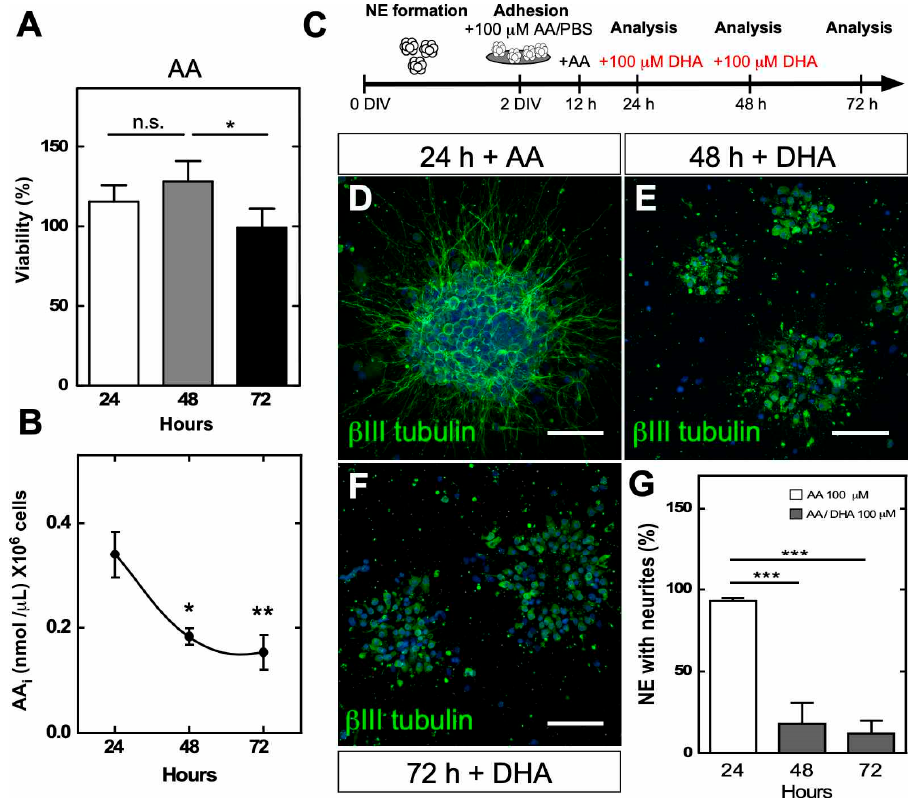
Figure 3. Treatment of NEs differentiated in vitro with DHA impacted neuritic growth. ( A ) Viability analysis of NEs treated with AA for 24, 48 and 72 h. All data are representative of three separate experiments. Nonparametric ANOVA statistical analysis, Tukey posttest, * p < 0.05; n.s., not significant. ( B ) Intracellular AA concentration during AA treatment. All data are representative of three separate experiments. Parametric ANOVA statistical analysis, Tukey posttest, * p < 0.05; ** p < 0.01. ( C ) DHA treatment protocol used in NE adhesion. ( D – F ) β III tubulin (green) analysis in NEs treated with 100 μ M AA for 24 h ( B ) or 100 μ M AA for 24 h followed by 100 μ M DHA until 48 h ( E ) or until 72 h ( F ). Scale bar, 60 μ m. ( G ) NE neurite quantification at each treatment time point. A “neurite” was considered a cellular extension positive for β III tubulin and at least 10 μ m in length. All data are representative of three separate experiments. Parametric ANOVA statistical analysis, Tukey posttest, *** p < 0.001.